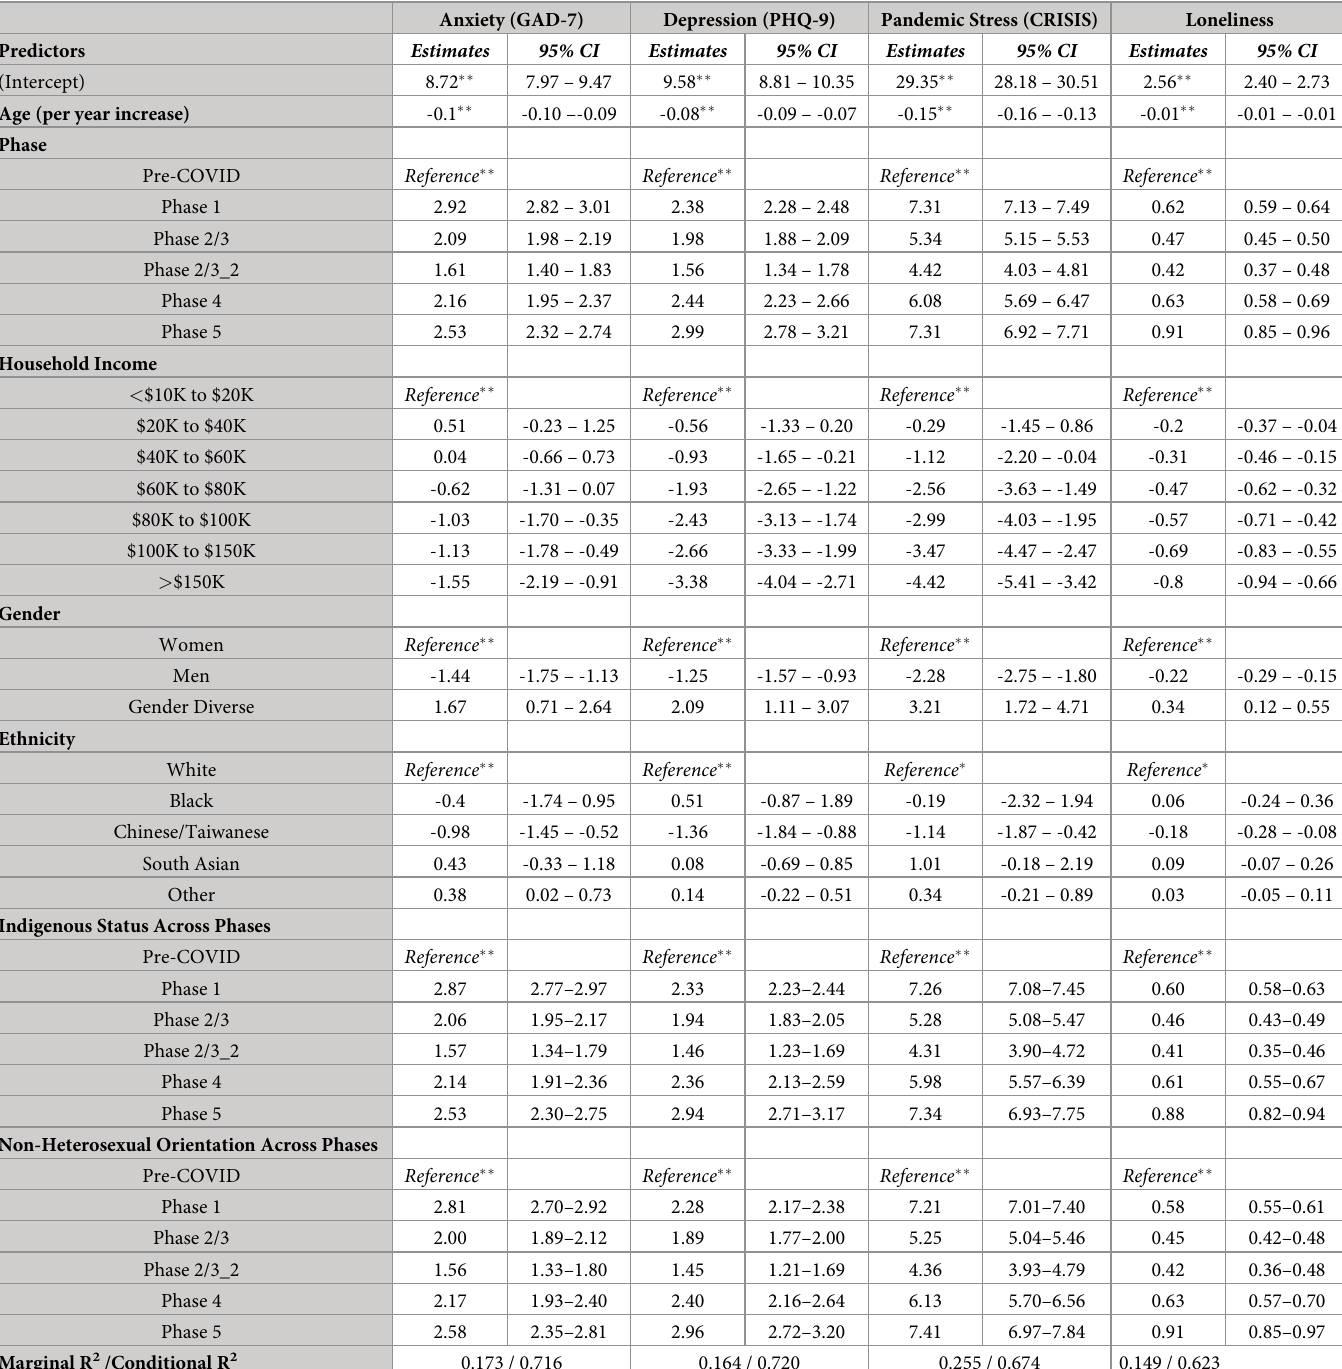
Table 2. Impact of sociodemographic factors and pandemic phase on psychosocial